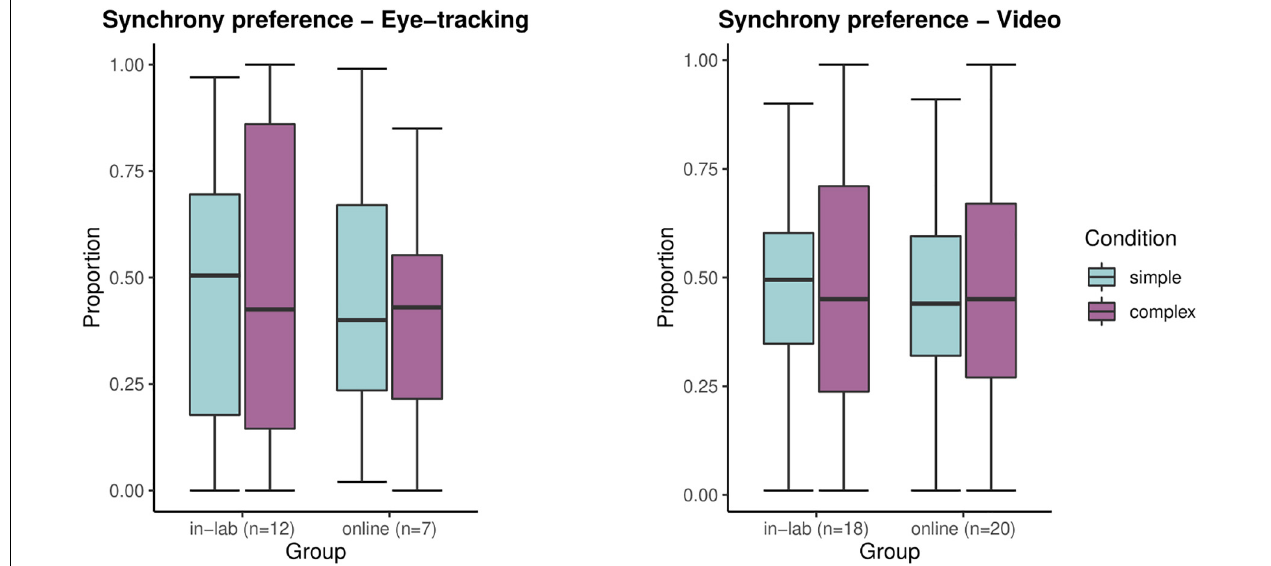
FIGURE 9 | Synchrony preference (proportion of looking times to the synchronous stimulus versus to both AOIs) compared between experimental settings (in-lab, online) and conditions (simple, complex) for each method (eye-tracking, video